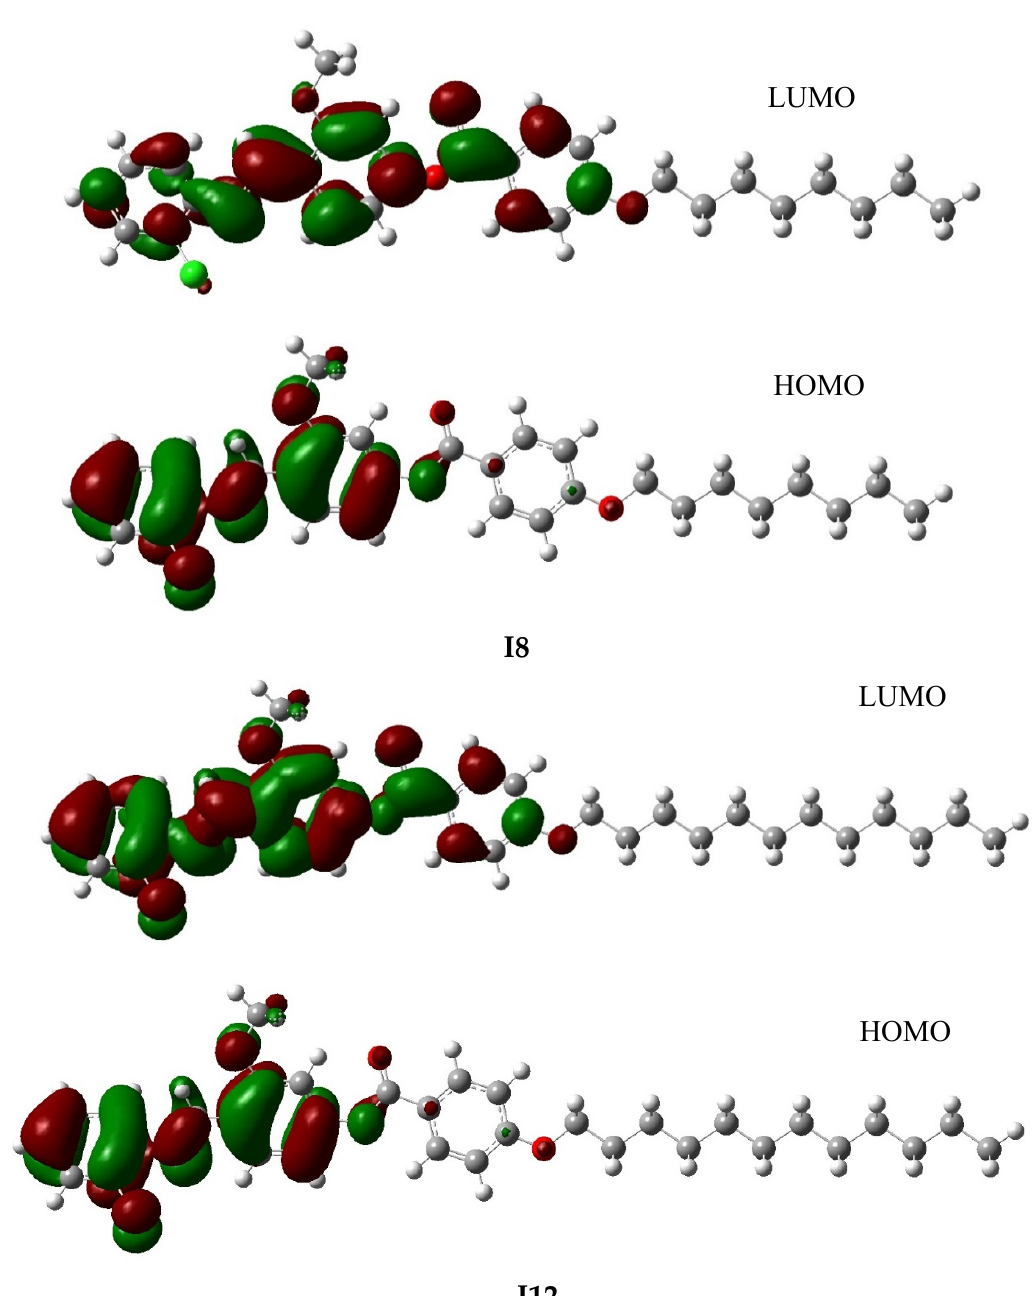
Figure 8. Frontier molecular orbital calculated at B3LYP/6-31g (d,p) for the I8 and I12 derivatives.